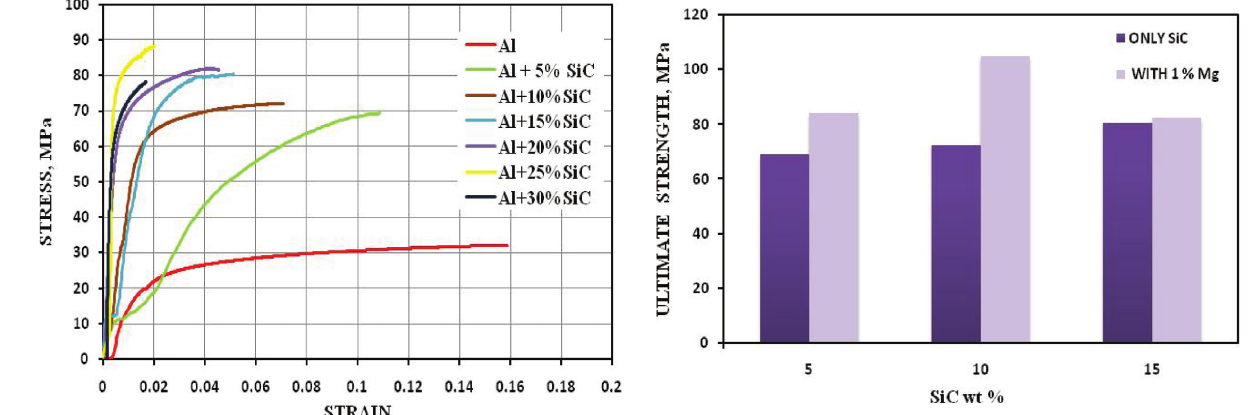
Fig. 3: Stress-strain curve of Al and Al based composite with various wt% of SiC